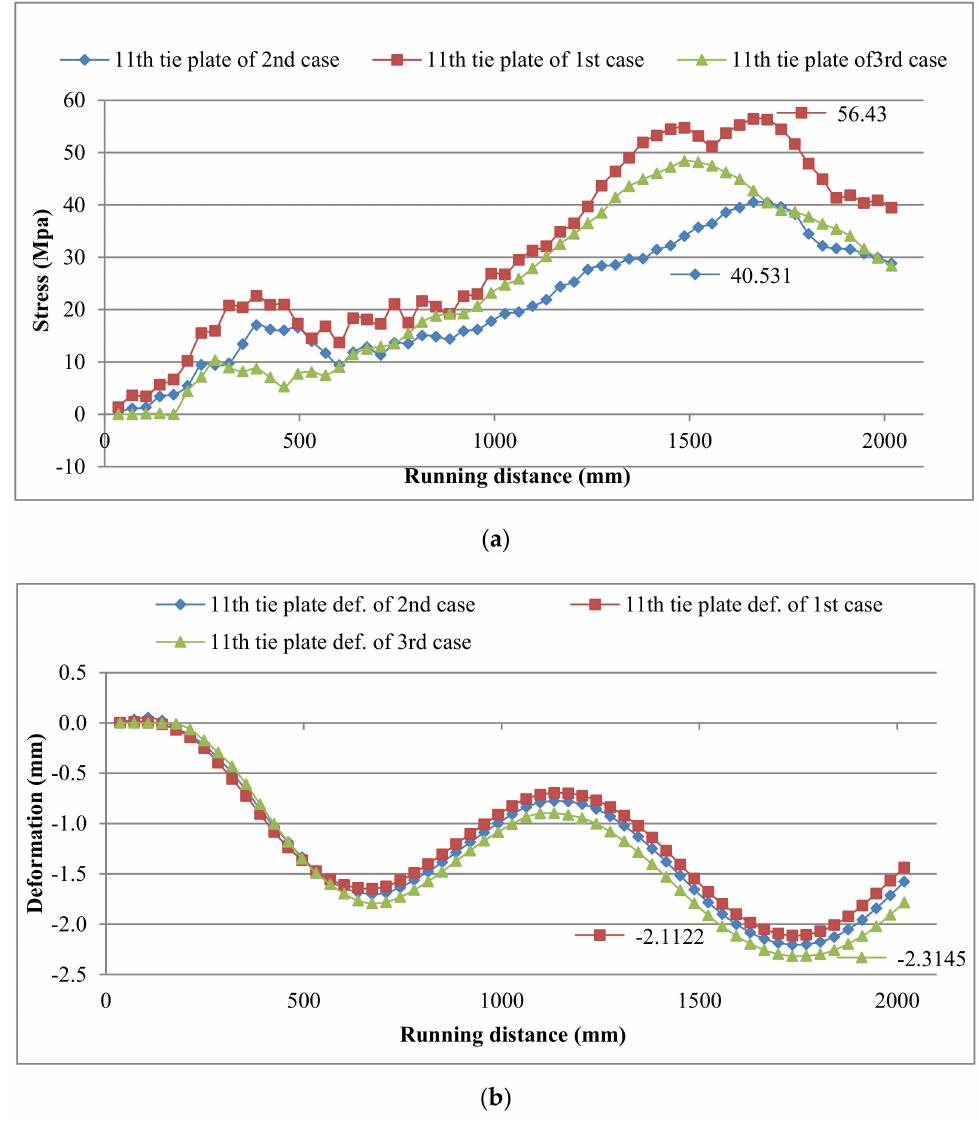
Figure 13. The 11th tie plate: ( a ) stresses; ( b ) deformation. Stresses increase gradually in the first case of the 11th sleeper, reaching the highest value of all cases, i.e., 0.66 MPa, as observed in Figure